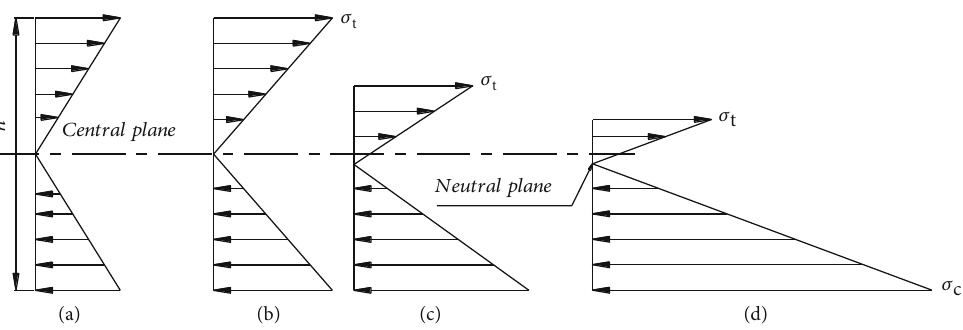
Figure 3: Longitudinal stress change in fracture section of the stratum.